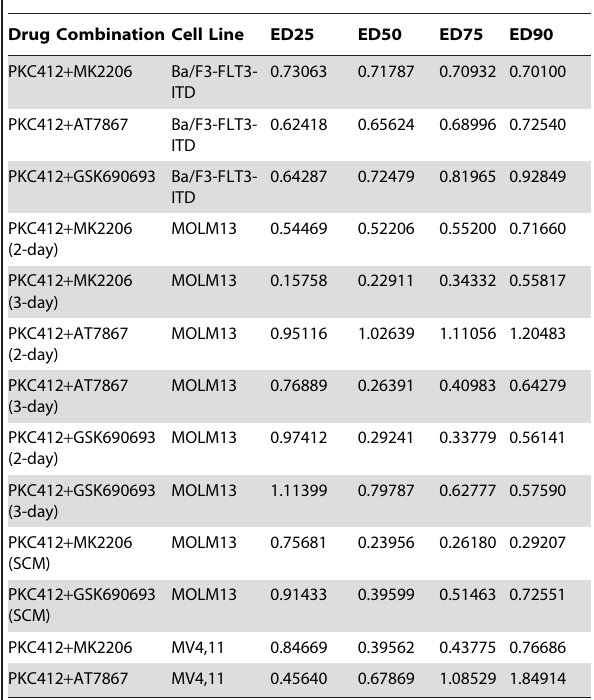
Data shown here correspond to dose-response curves shown in Figures 5 and 6 and Figure S8. Interpretation of combination indices is provided in the Materials and Methods section.